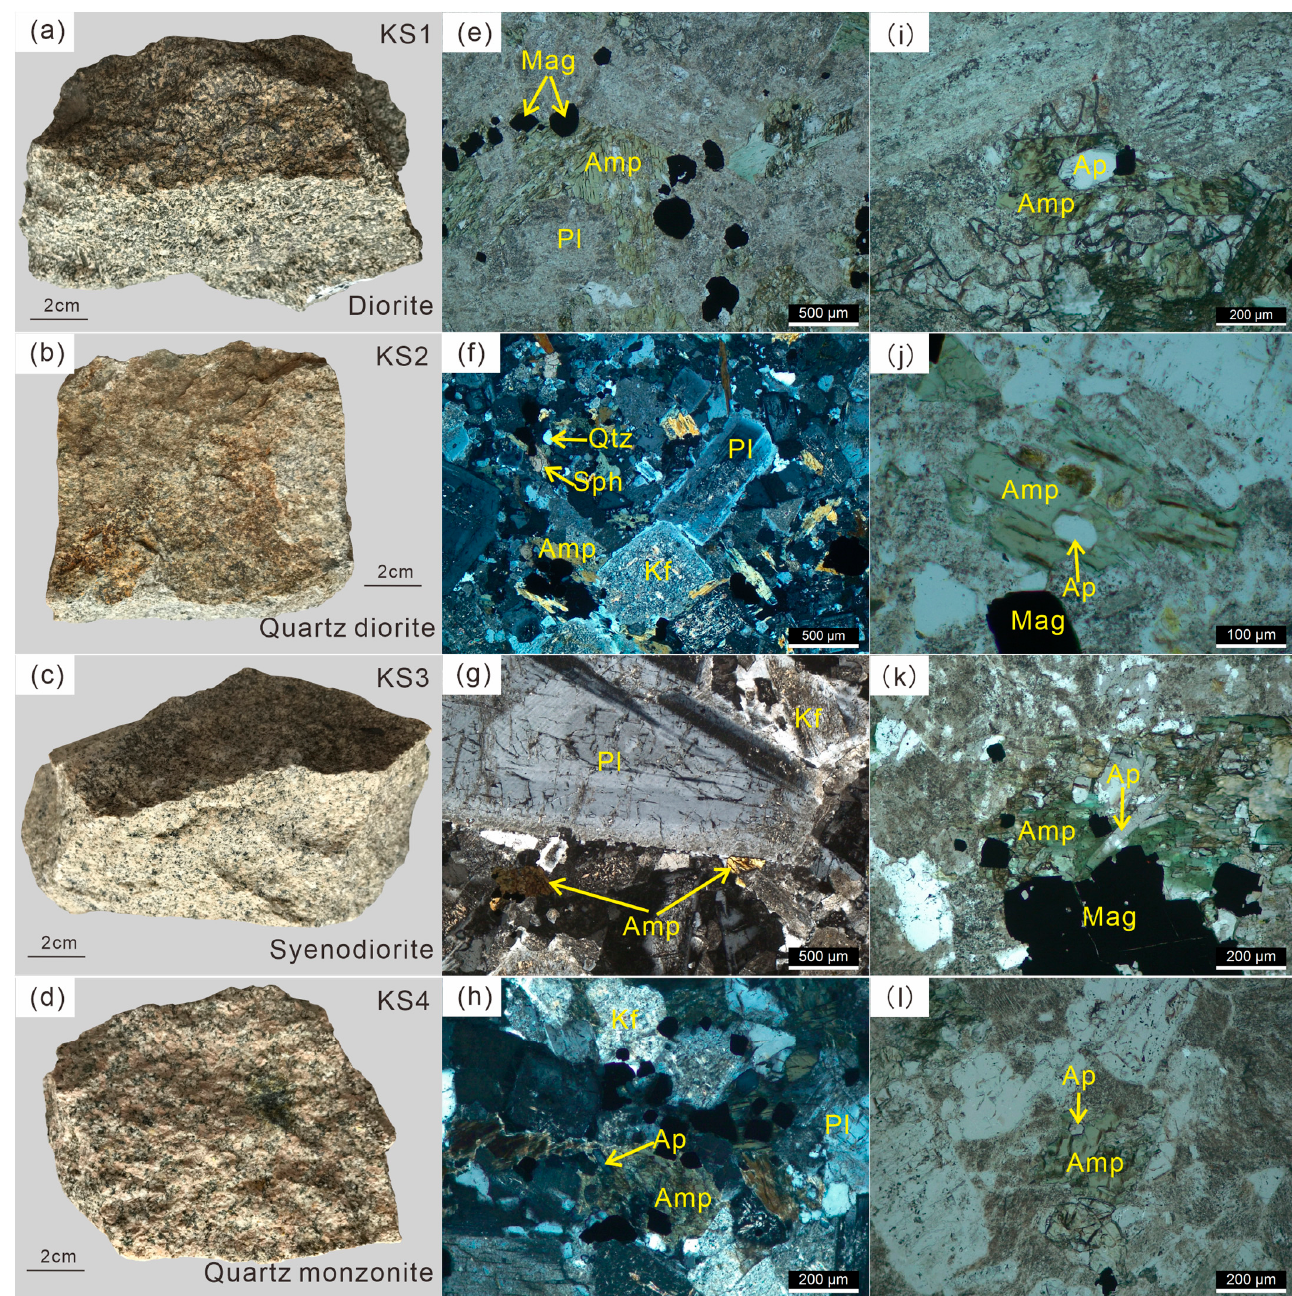
Figure 5. Sample features of the Kuangshan complex. ( a ) Diorite (KS1); ( b ) Quar tz diorite (KS2); ( c ) Syenodiorite (KS3); ( d ) Quar tz monzonite (KS4); ( e ) Diorite (KS1), under plane-polarized light; ( f ) Quartz diorite (KS2), under cross-polarized light; ( g ) Syenodiorite (KS3), under cross-polarized light; ( h ) Quartz monzonite (KS4), under cross-polarized light; ( i – l ) Apatite coexisting with amphibole in some samples.